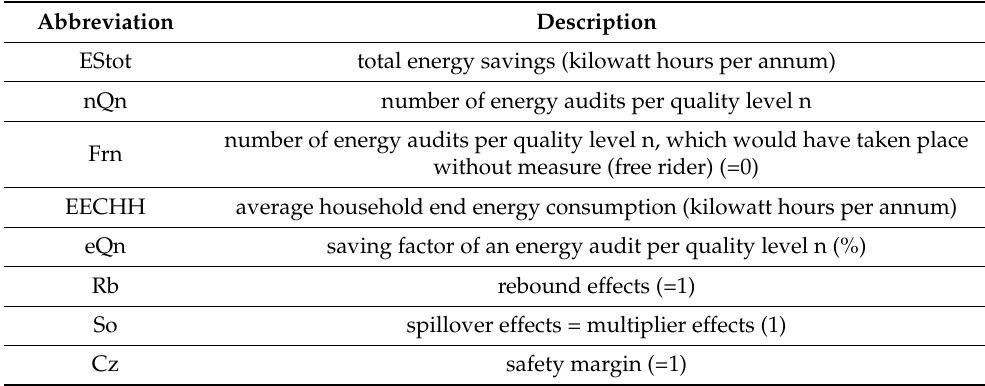
Table 2. Overview of default-formula